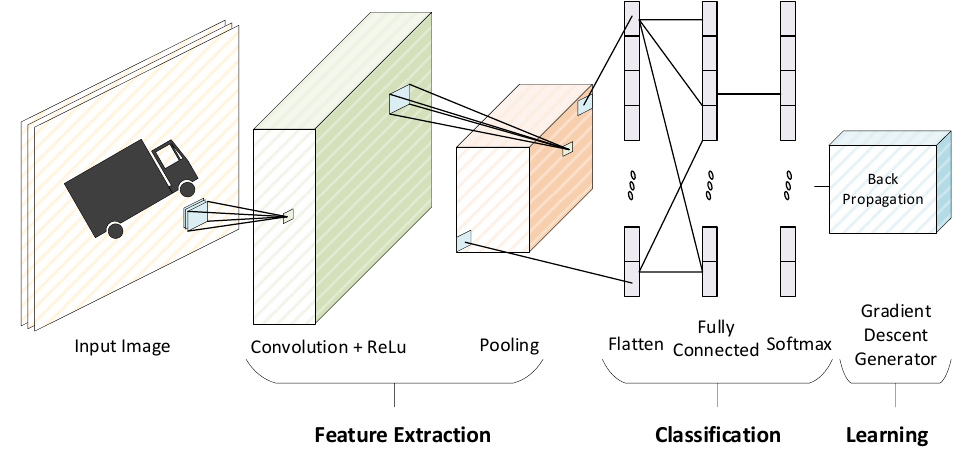
Figure 1. General architecture of CNN.